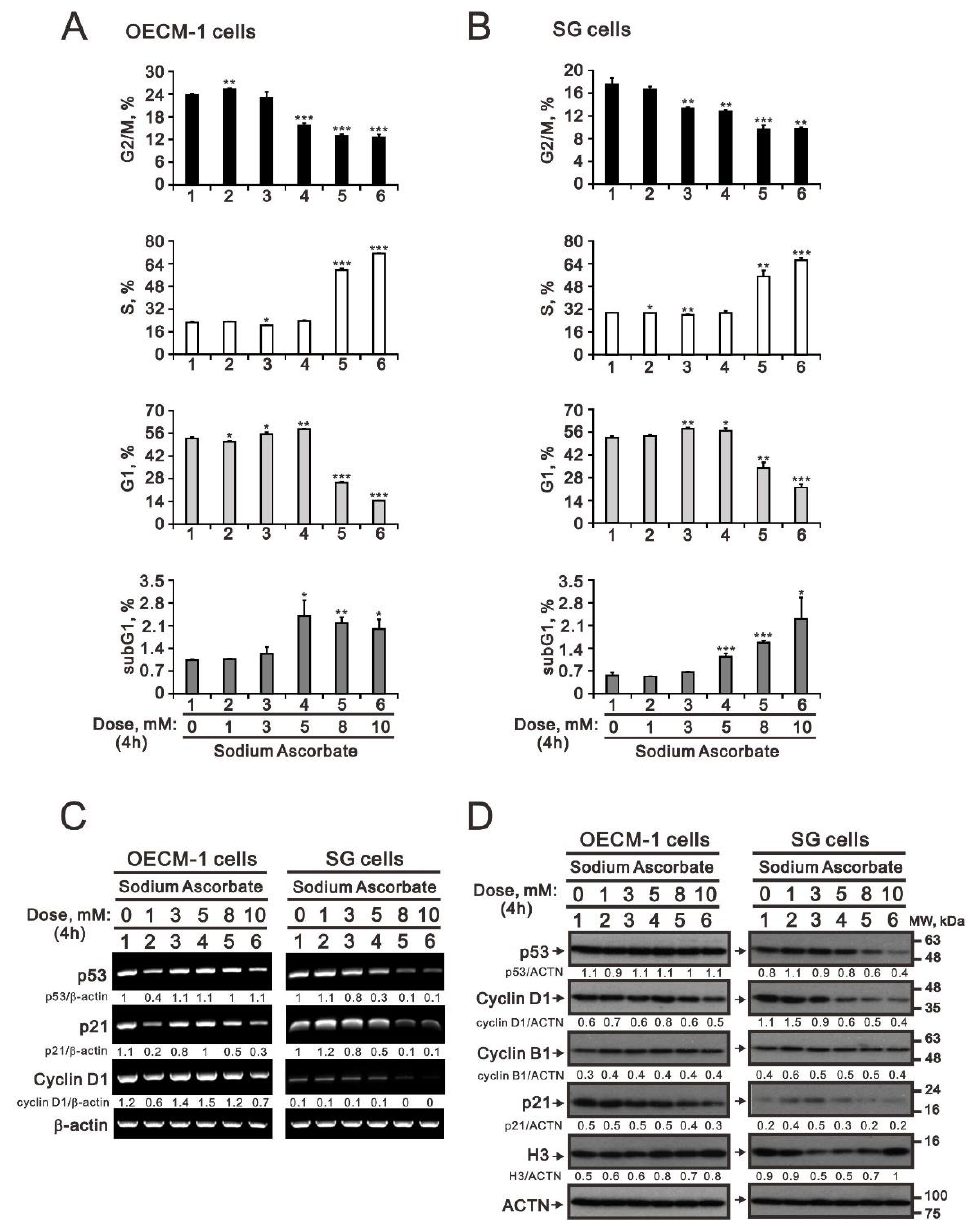
Figure 2. Effects of L-ascorbic acid and sodium ascorbate on the cell-cycle profile and related gene and protein expressions in OECM-1 and SG cells. OECM-1 (3.5 × 10 5 ) and SG (3.5 × 10 5 ) cells were cultured in 6-well plates and treated with the indicated concentrations of L-ascorbic acid and sodium ascorbate for 4 h. They were then subjected to ( A , B ) cell-cycle profile analysis, ( C ) RT-PCR analysis, and ( D ) Western Blot analysis. ( C ) RT-PCR analysis was performed with 1 µg total RNA and b-actin was a loading mRNA control. ( D ) The cell lysates (30 µg total proteins) were subjected to Western Blot analysis using antibodies against the indicated proteins. ACTN was a loading-protein control. ( A , B ) Bars depict the mean ± SD of three independent experiments. Student’s t -tests were analyzed and compared with vehicle. * p < 0.05, ** p < 0.01, and *** p < 0.001. The mRNA and protein bands ( C , D ) were quantified through pixel density scanning and evaluated using Image J, version 1.44a (http://imagej.nih.gov/ij/) (accessed on 1 February 2023). The ratios of mRNA/β -actin ( C ) and protein/ACTN ( D ) were listed in the OECM-1 and SG cells. The dose-dependent increasing trend of the population of the S phase suggested that cellular proliferation might be involved in the cytotoxicity of oral cells. Hence, we applied BrdU proliferation analysis to examine the effect of sodium ascorbate in OECM-1 and SG